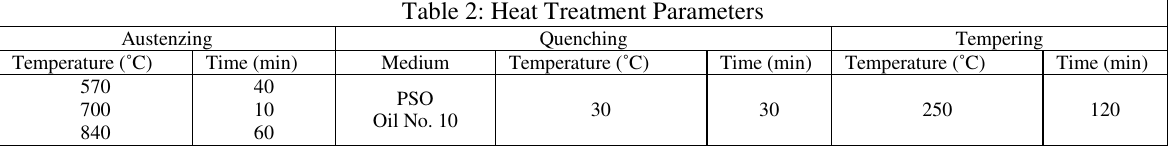
Table 2: Heat Treatment